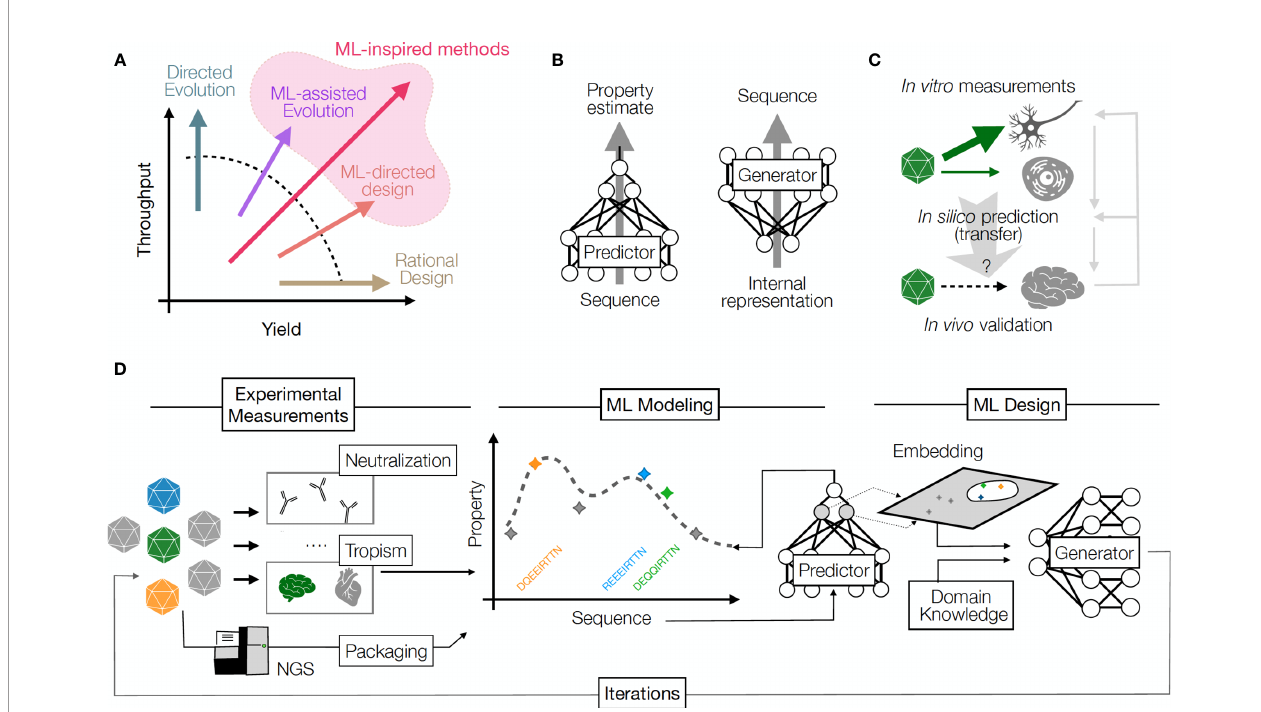
FIGURE 1 | (A) A comparison of throughput (number of samples) and yield (fraction of successful samples generated per attempt) for multiple protein design approaches. Rational design increases yield, directed evolution leverages throughput, and ML methods increase the likelihood of success by balancing yield and throughput. (B) Predictive ML models map sequences to their functional properties, while Generative methods can turn an internal data representation back into sequences, producing desirable samples. (C) An example of transfer learning whereby a model transfers information across cell types and experimental contexts: a model learns based on in vitro capsid performance in diverse cell transduction experiments (including neurons), then is applied to predict the result of in vivo transduction in the brain neurons, when such experimental data is sparse or missing. Information from in vivo validation of the predicted capsid performance is used to re fi ne model performance and understand the relationship between in vivo and in vitro assays. Right grey arrows illustrate the iterative power of this approach, which re fi nes predictive and generative models over time. (D) The design cycle starts with HT screening and measurements of several AAV capsid variant properties. These properties are then used to train predictive models that can impute the property for unseen sequences (predictor model) and can be used to build helpful representations (embeddings), which can then be integrated with auxiliary input (e.g., domain knowledge) to propose a batch of new sequences (generator model). The design process can be repeated in multiple iterations until desired capsids are